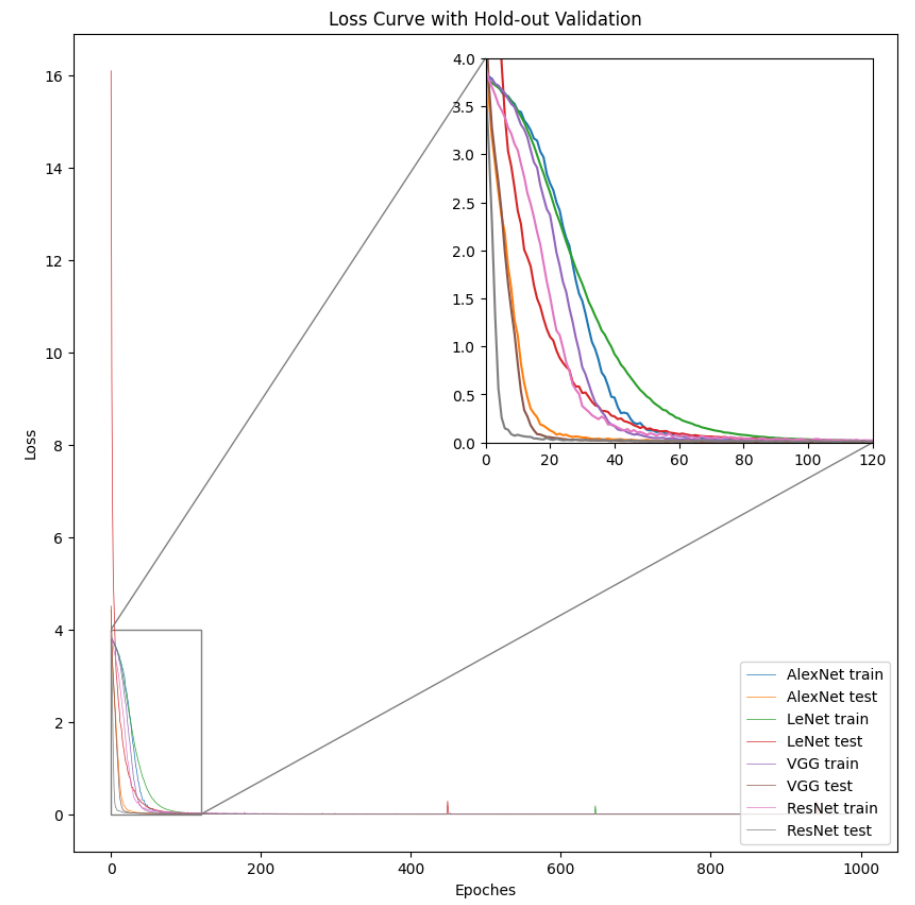
Figure 18. Loss curve comparisons for the LeNet training process, LeNet testing process, AlexNet training process, AlexNet testing process, VGG training process, VGG testing process, ResNet training process, and ResNet testing